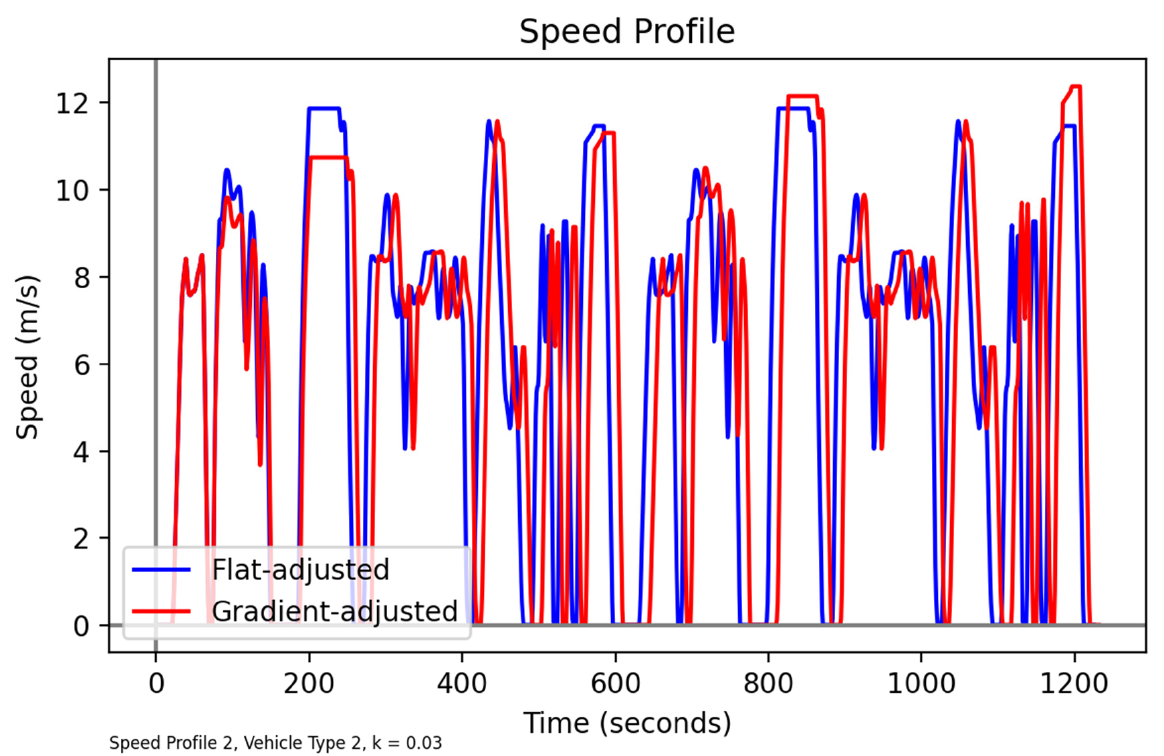
Figure 10. Comparison of adjusted speed profiles for Flat ( k = 0) and Gradient ( k = 0.03) cases (Both adjusted from WMTC Reference Cycle 2; Vehicle Type 2).